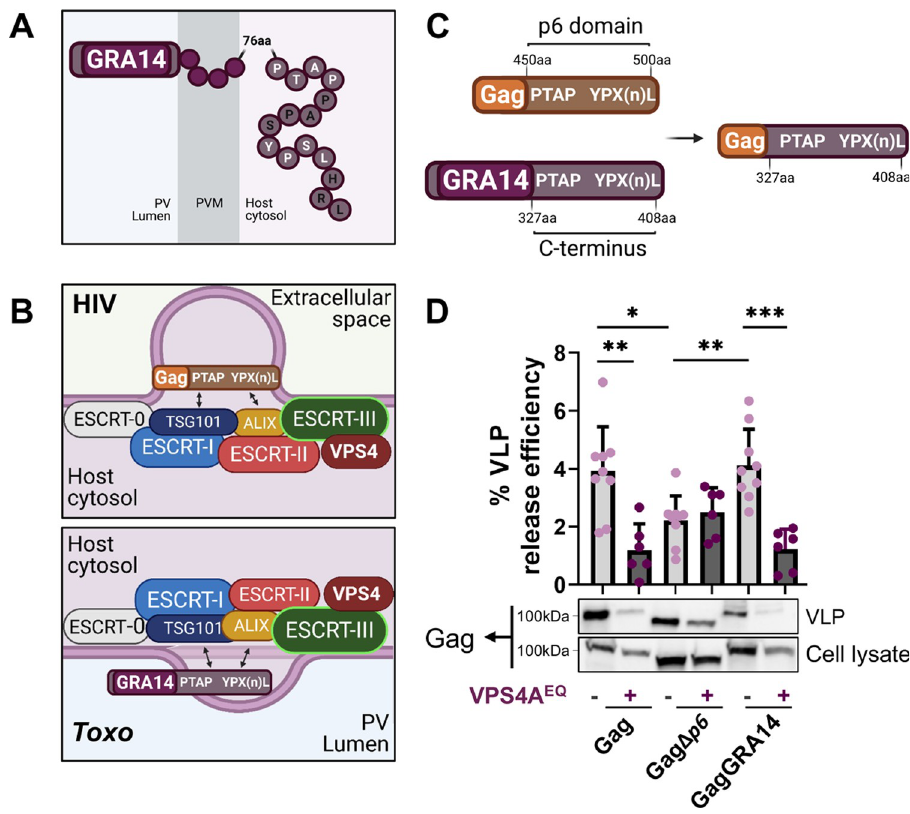
Fig 2. The GRA14 C-terminal domain facilitates ESCRT-dependent release of VLPs. A. Schematic of TgGRA14 topology at the PVM. The TgGRA14 C-terminus encoding the late domain motifs PTAP and YPX (n) L is exposed to the host cytosol whereas the N-terminus is exposed to the PV lumen. B. Schematic representation of the predicted recruitment of the ESCRT recruitment by TgGRA14 through the late domain motifs in comparison with their known function in HIV-1 budding. The PTAP and YPX (n) L motifs can mediate interactions with host ESCRT-I components TSG101 and the ESCRT accessory protein ALIX, respectively. C. Experimental design for the substitution of the HIV-1 Gag p6 domain for the TgGRA14 C-terminus portion encoding late domain motifs to generate the GagGRA14. aa, amino acid. Note that the aa numbering in the hybrid Gag/GRA14 is for GRA14. D. Analysis of VLP release by HIV-1 Gag, Gag Δ p6 and GagGRA14. Representative immunoblots of VLP release include top: VLP release sample (100%) and bottom: cellular lysate sample (4%). The role for the ESCRT machinery in GagGRA14 release was assessed by disruption of the ESCRT machinery using the VPS4A dominant negative form (VPS4A EQ ). Data represents the mean from � 3 biological replicates. Statistical analysis was by Student’s t-test. Only statistical differences are shown. � p < 0.05, �� p < 0.01, ��� p <